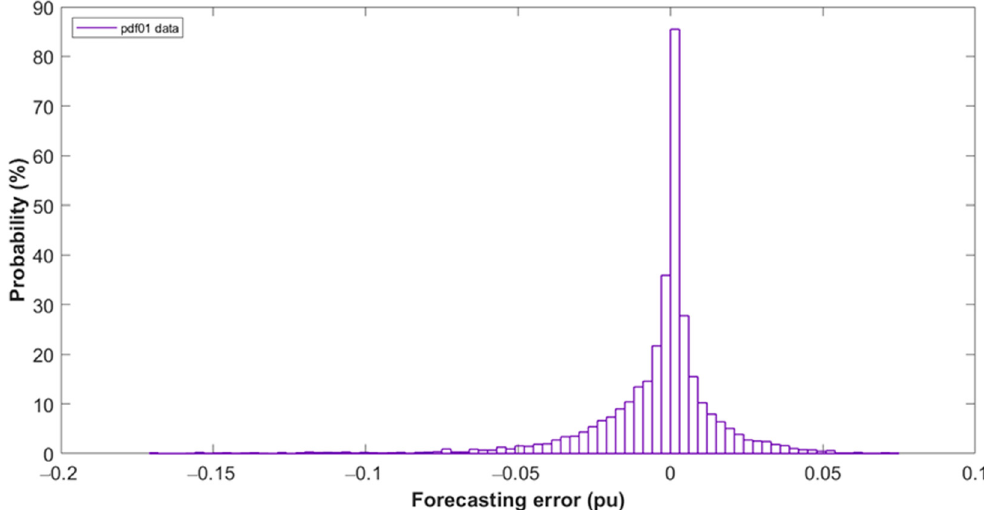
Figure 1. The forecasting error of solar power (spring) in the first interval (probability density function (pdf) 01).